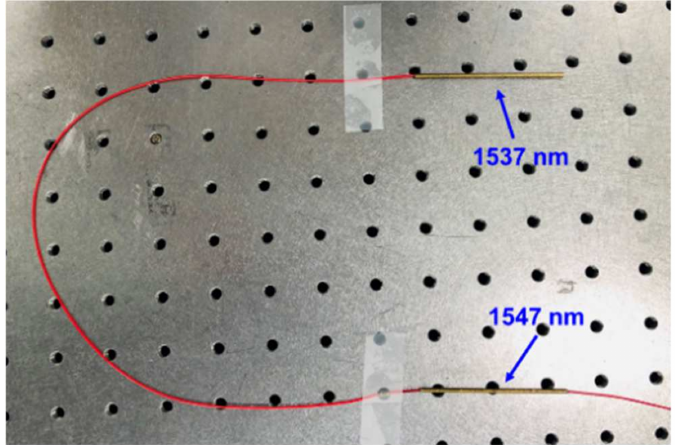
Figure 5. Photograph of a packaged optical temperature sensor. Figure 6a,b present top-view images of the produced doubled-layered sensor